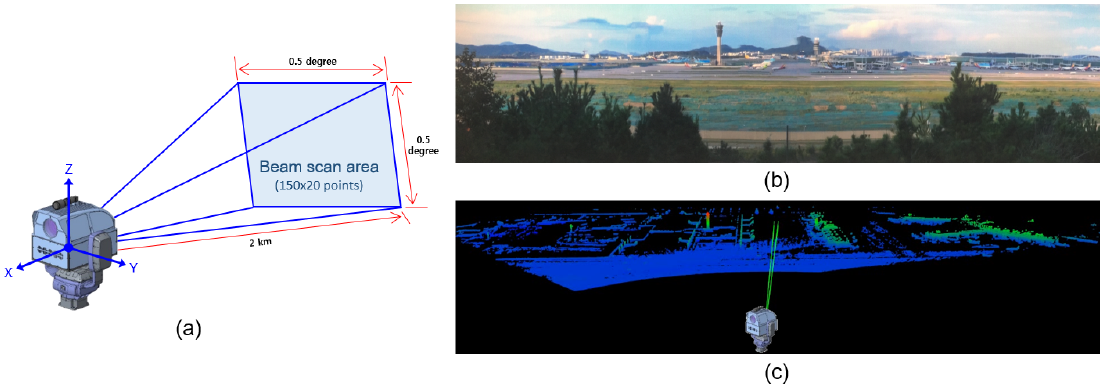
Figure 4. LADAR concept and the example dataset of an airport. ( a ) LADAR hardware design and scanning view, ( b ) experimental environment (airport), ( c ) an example sensing